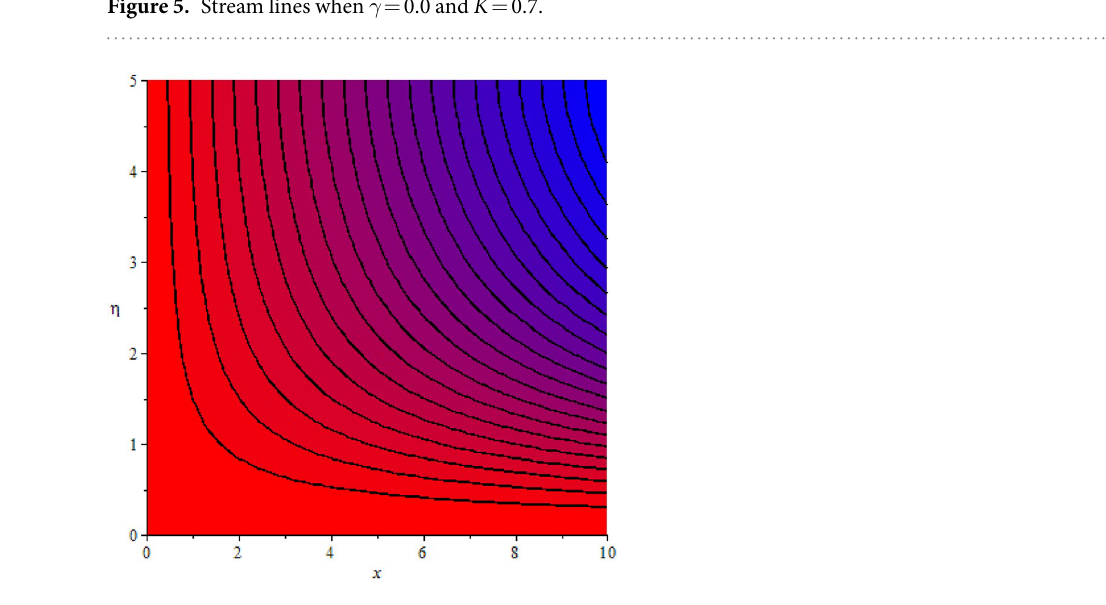
Figure 6. Stream lines when γ = 0.0 and K =